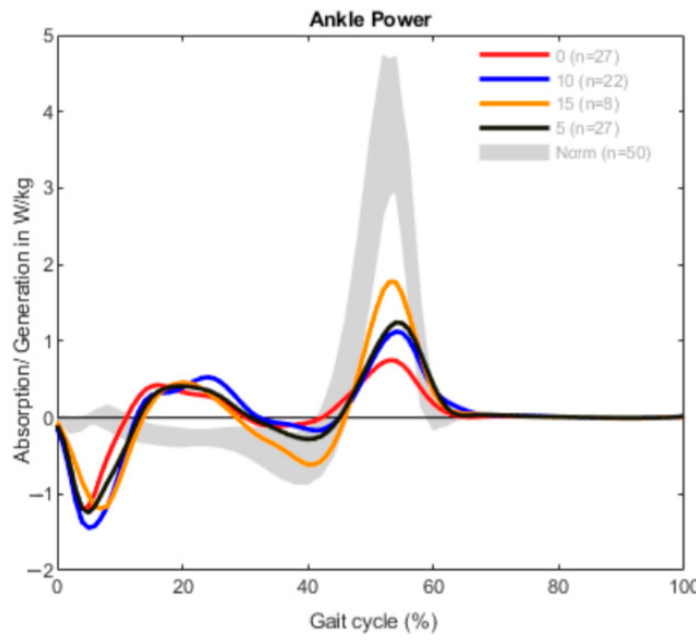
Figure 3. Ankle power measurement in the bilateral group ( n = 84).